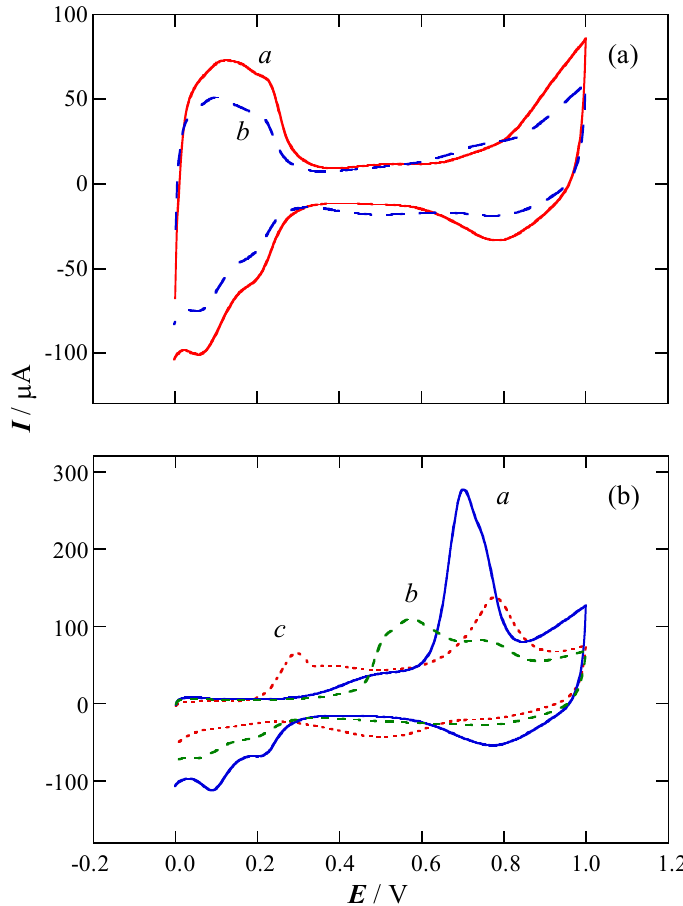
Figure 1. ( a ) Cyclic voltammograms of Pt(Cu)/C (curve a ) and Pt ‐ Ru(Cu)/C (curve b ) in deaerated 0.5 M H 2 SO 4 after a Cu electrodeposition charge ( q Cu ) of 30 mC following the sequence i ; ( b ) CO stripping experiments on Pt(Cu)/C for q Cu of 45 (curve a ) and 20 mC (curve c ) and on Pt ‐ Ru(Cu)/C for q Cu = 45 mC (curve b ). Sweep rate 20 mV s − 1 .